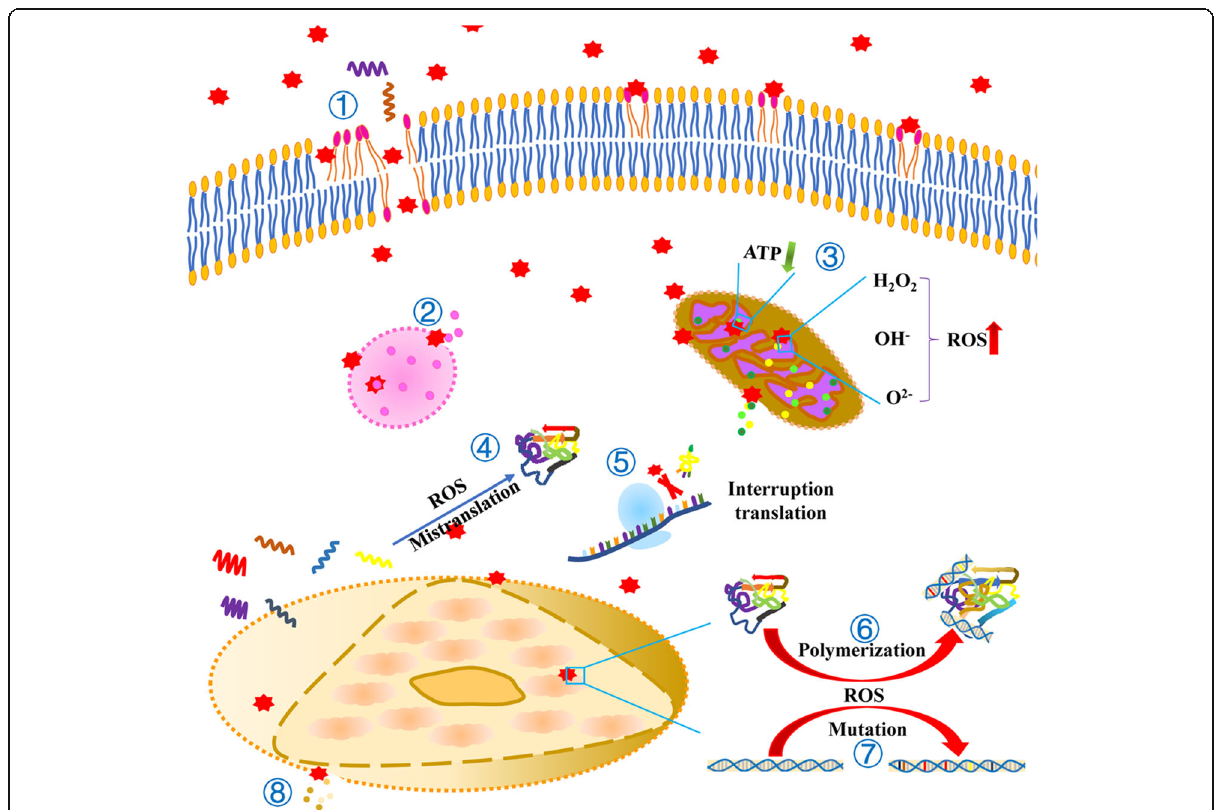
Fig. 3 Cellular events induced by NPs. ① NPs contribute to the destruction of the cell membrane and to lipid peroxidation. ② The lysosomal membrane is destroyed by NPs and results in the release of their contents. ③ The mitochondrial membrane is damaged by NPs, leading to content release. NPs reduce the generation of ATP and increase the production of ROS. ④ The ROS induced by NPs results in the mistranslation of RNA. ⑤ NPs prevent the binding of tRNA to the ribosome. ⑥ The ROS induced by NPs result in the polymerization of proteins and DNA. ⑦ The ROS induced by NPs leads to DNA mutations ⑧ The nuclear membrane is destroyed by NPs, resulting in the release of its